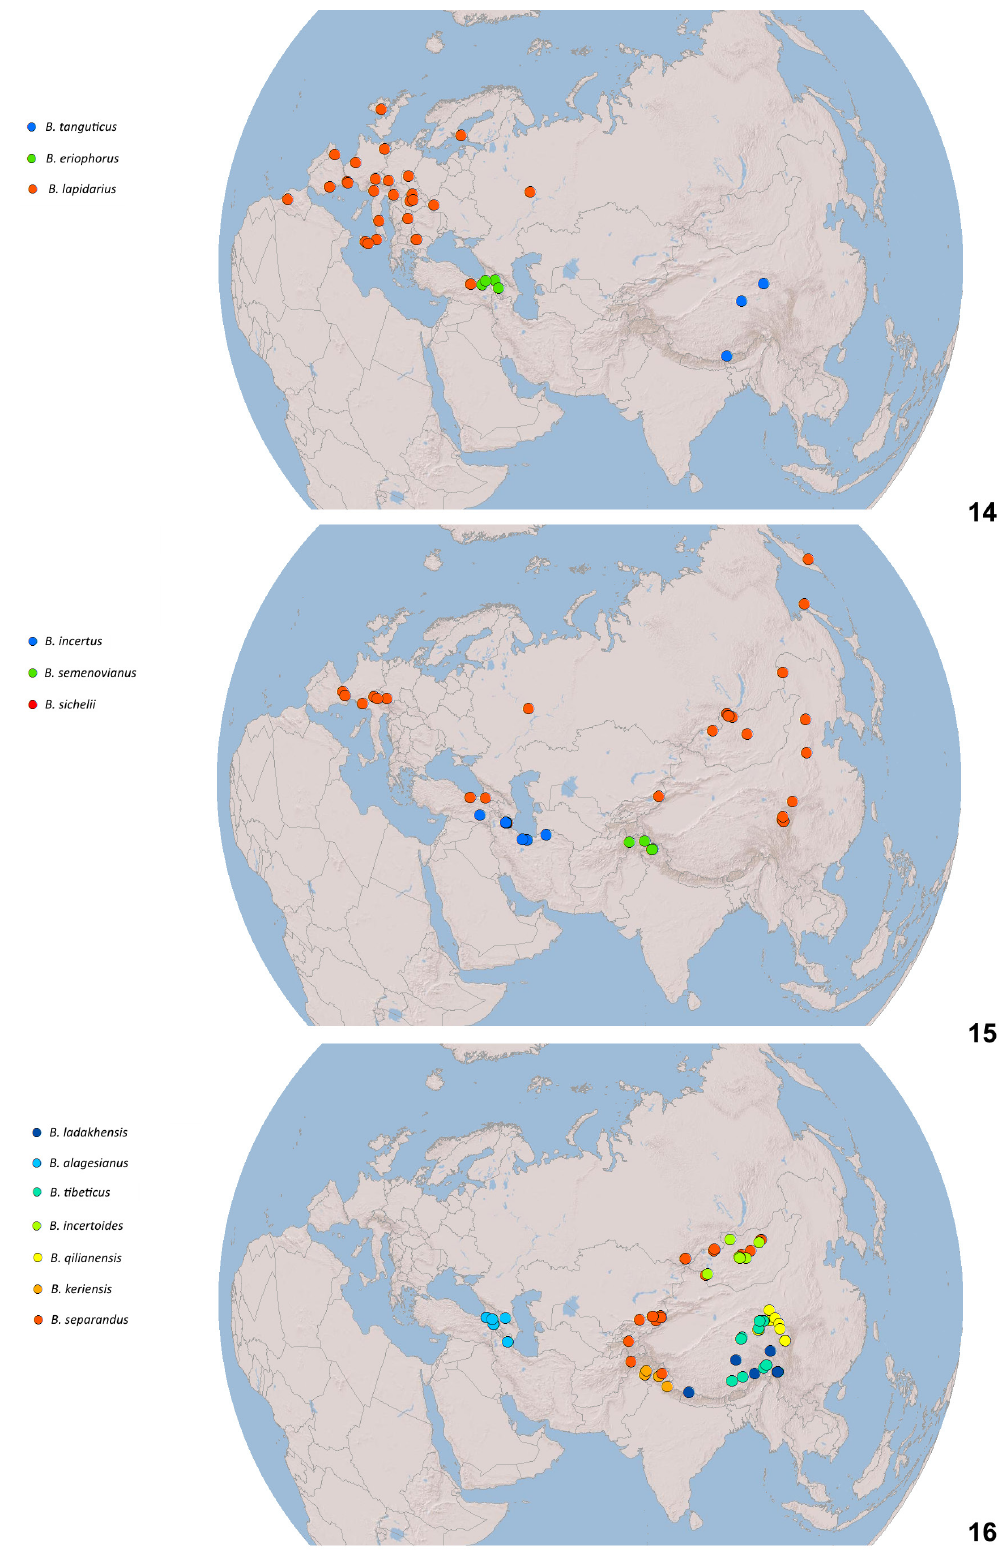
Figs 14‒16. Maps of sequenced samples as in Figs 12‒13. 14 . The tanguticus -group and the lapidarius - group. 15 . The sichelii -group. 16 . The keriensis